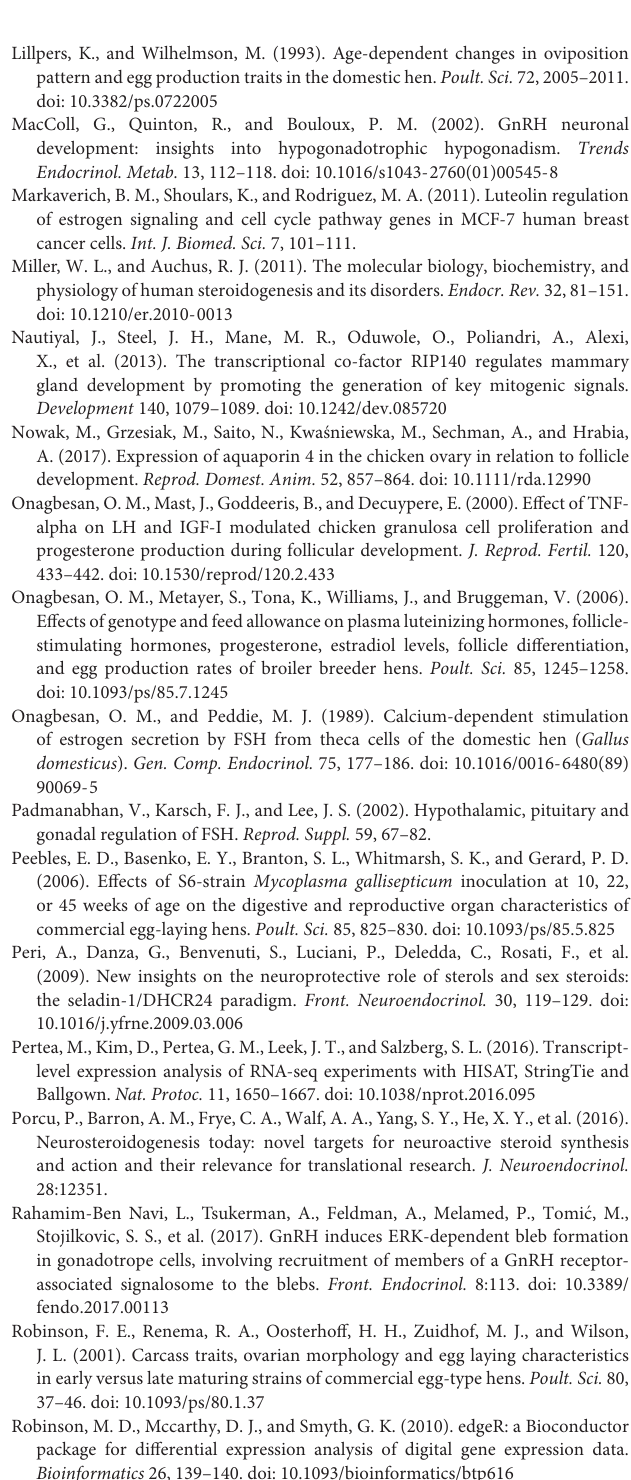
Supplementary Table 4 | The list of the significant KEGG classification of differentially expressed genes. Supplementary Table 5 | The list of gene primers sequencing used for qRT-PCR